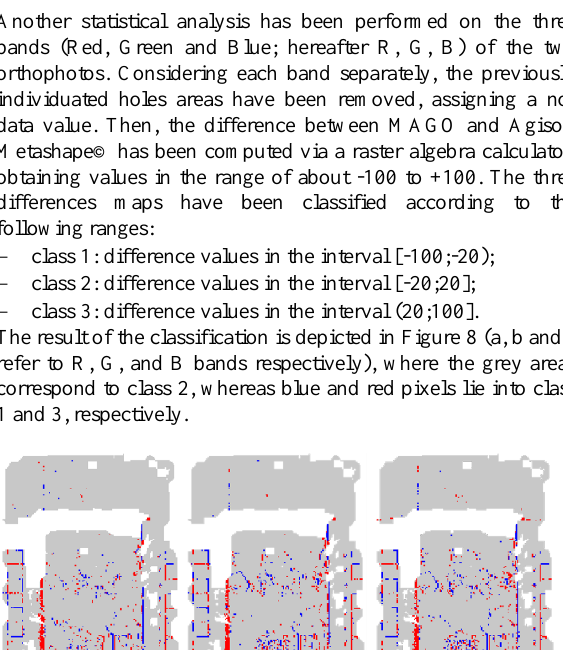
Figure 9. Summary of difference maps for the three bands. The grey and black pixels respectively represent areas of agreement and disagreement between the bands of the two orthophotos. The grey pixels represent the areas where the R, G and B bands present a difference value between MAGO and Agisoft Figure 8. Classification of difference maps (MAGO-Agisoft Metashape© within class 2, i.e. limited in the range of -20 and Metashape©) for R (a), G (b), and B (c) bands. +20, whereas the black pixels correspond to areas where the Class 1, 2 and 3 are represented in blue, grey and red, considered pixel lies in class 1 or 3 for at least one of the three respectively bands. Summarizing, the grey pixels can be interpreted as areas of limited differences for the three bands, namely areas where the two orthophotos are quite similar. Conversely, the black pixels highlight a disagreement of the different bands of the two orthophotos, and they will be object of future